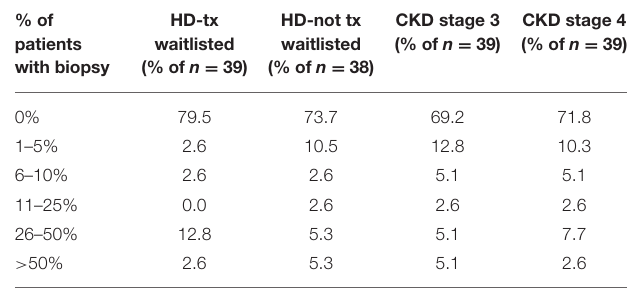
TABLE 11 | HCV genotyping practices (China Medical Director HCV survey, 2021). Genotyping practice